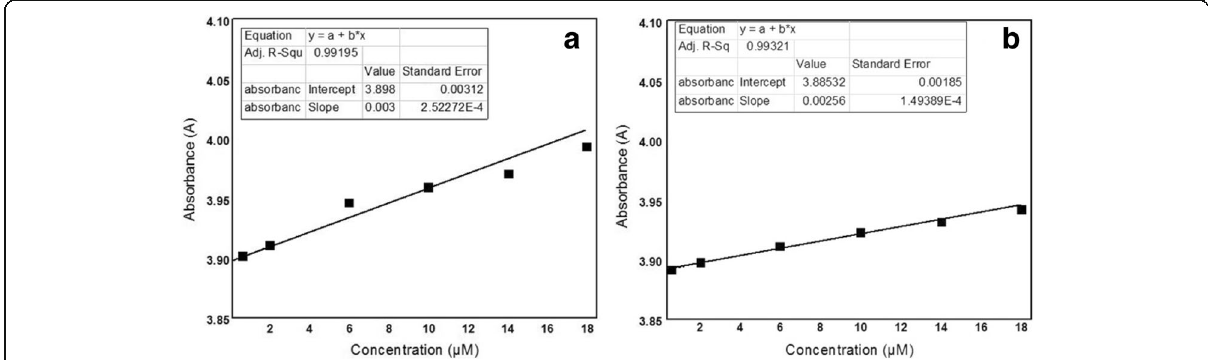
Fig. 4 The calibration curve of a histidine – GNPs and b histamine – GNPs at λ max 527